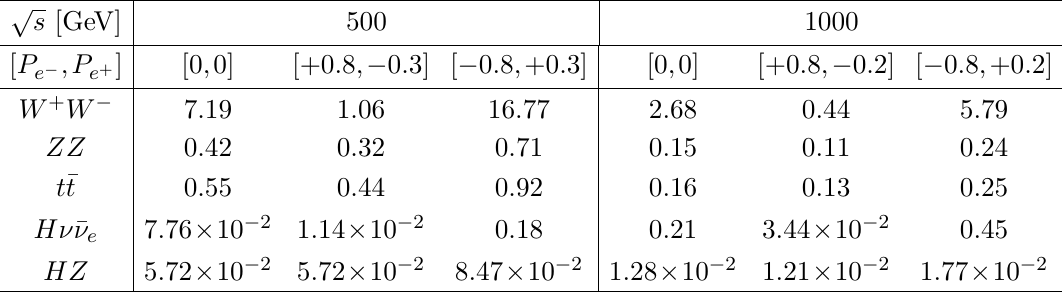
Table 1 . Production cross of the major background processes to the mono-Higgs channel in e + e − √ √ collisions at s = 500 GeV and s = 1000 GeV. The cross sections, given in picobarn, are calculated at the Leading-Order (LO) in perturbation